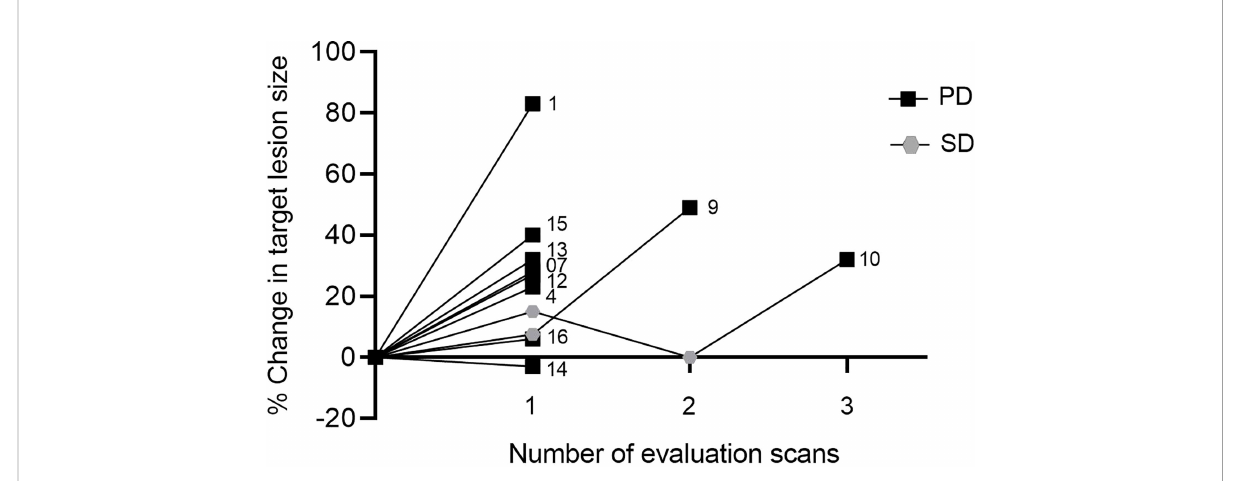
FIGURE 4 Spider plot showing changes in tumor size on evaluation scans for each patient. Patients were evaluated every three months. Numbers indicate patient ID. SD, stable disease; PD, progressive